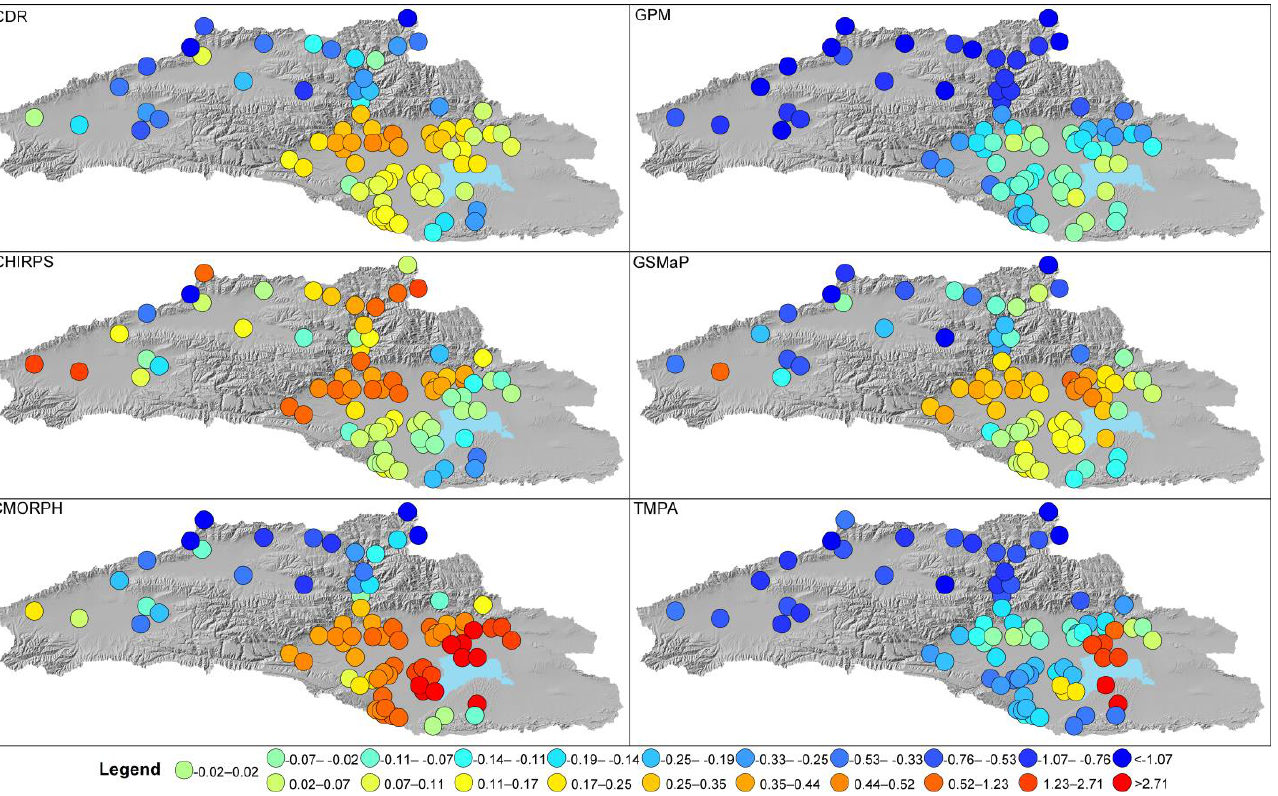
Figure 6. Distribution of ME between satellite datasets and measured data at different stations in the basin.